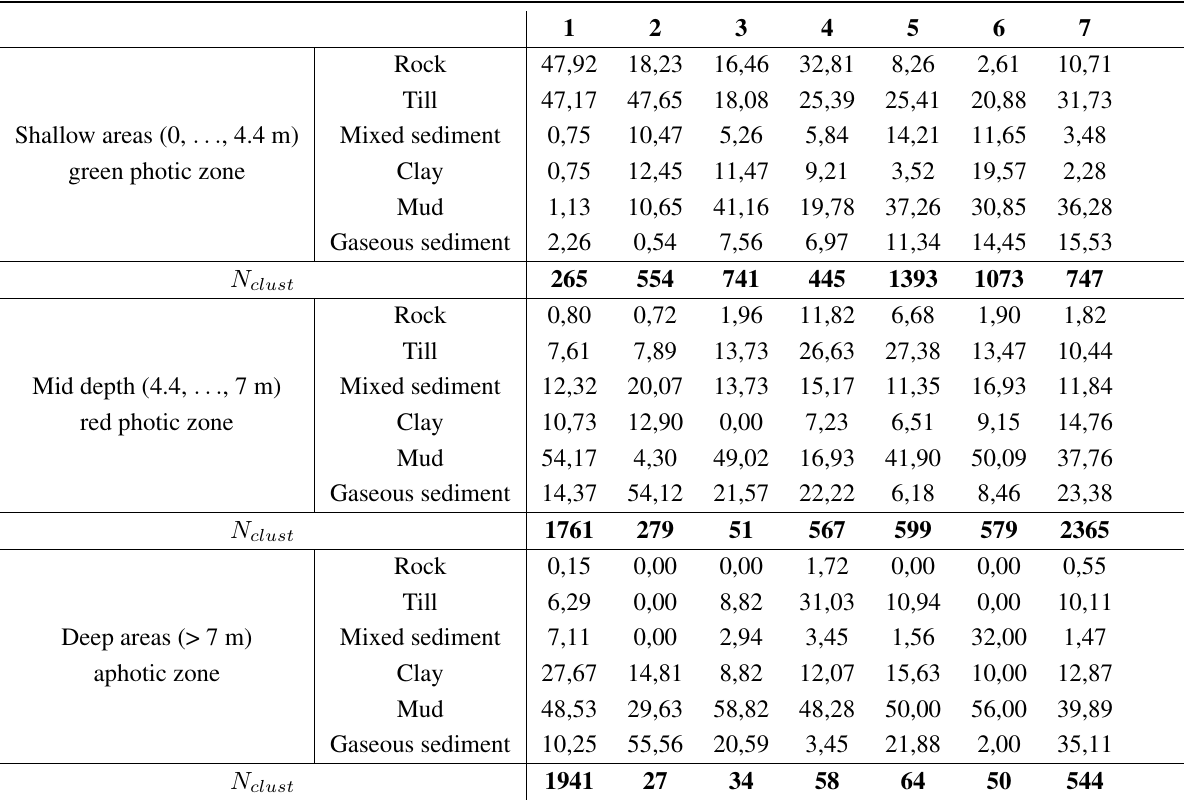
Table 5. Positive predictive value (PPV) of the obtained clusters with respect to the substrate class and vegetation zone. Here, PPV is calculated separately for the three vegetation zones.